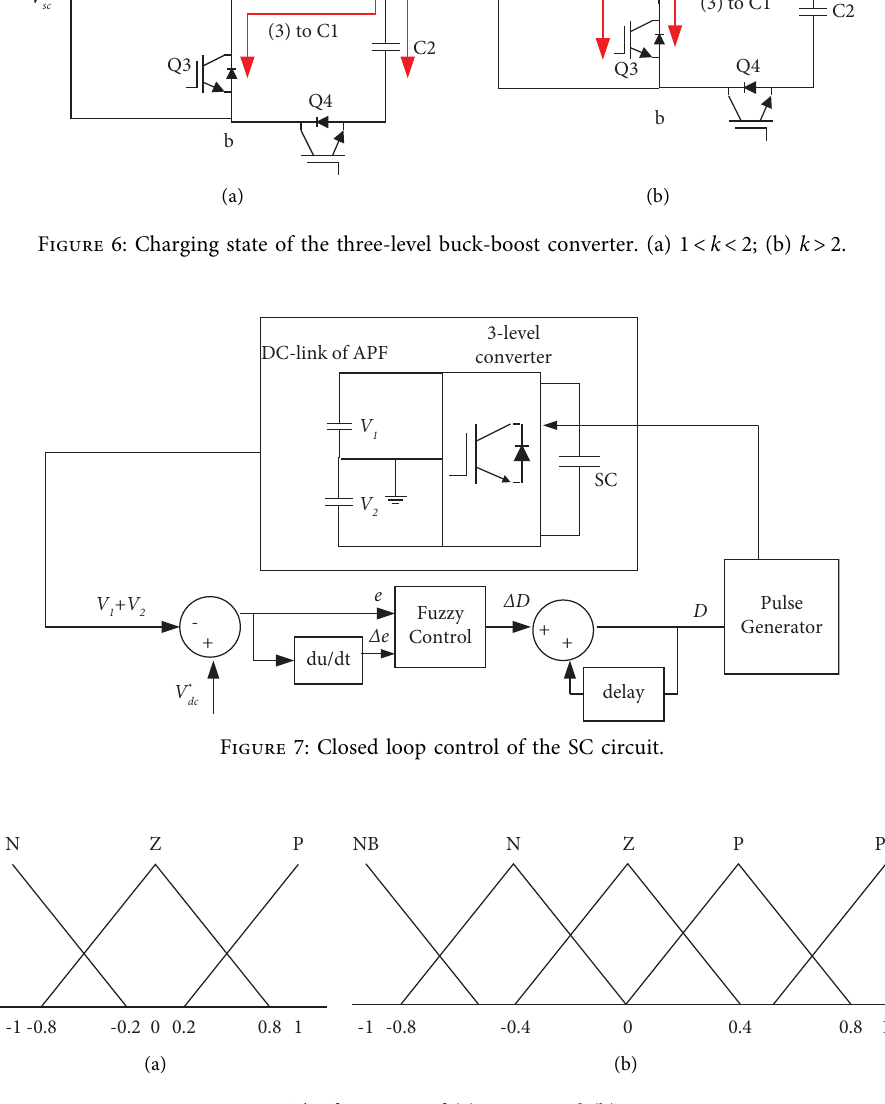
Figure 8: Te fuzzy sets of (a) inputs and (b)